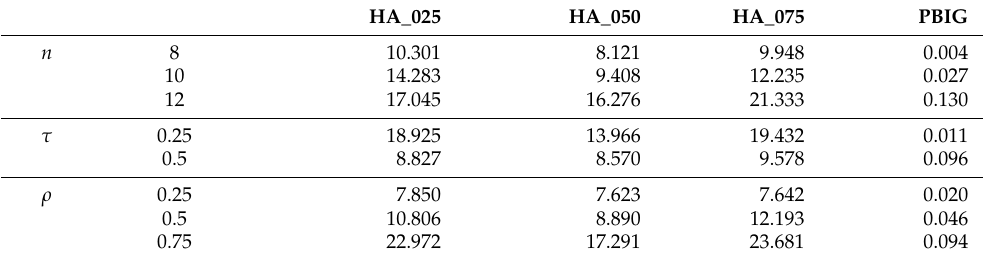
Table 3. The AEPs of the heuristics and the PBIG algorithm.